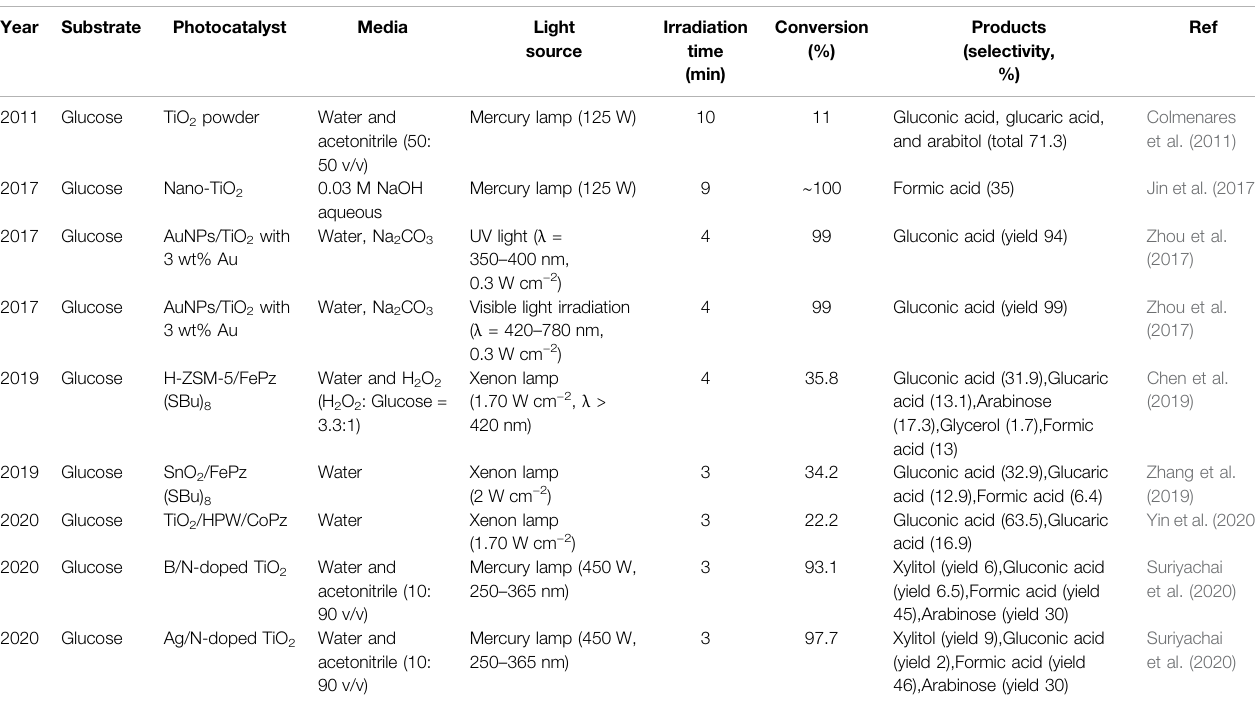
TABLE 2 | Photocatalytic conversion of glucose in the